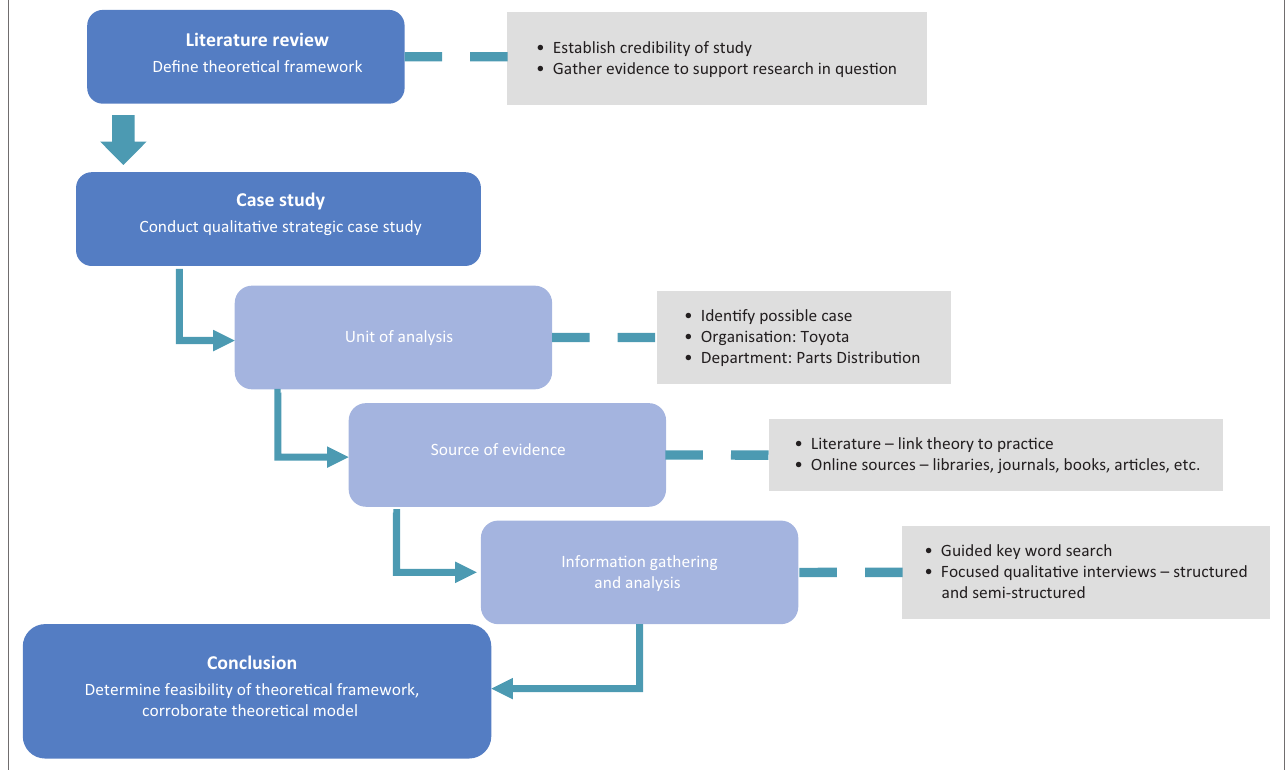
FIGURE 2: Research approach and